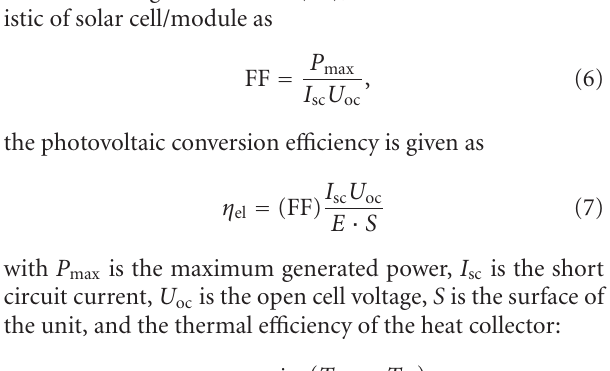
The heat can be drawn from the cells due to the conduction, convection, and radiation. The heat drawn from the modules during operation may be utilized in various